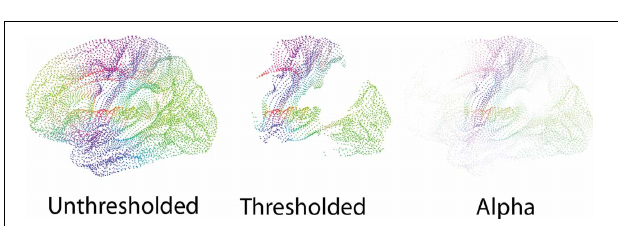
FIGURE 7 | Thresholded connectivity for an example point glyph, represented with different coloring options: the orientation of the connexel (Left) or the associated connectivity value (Right).